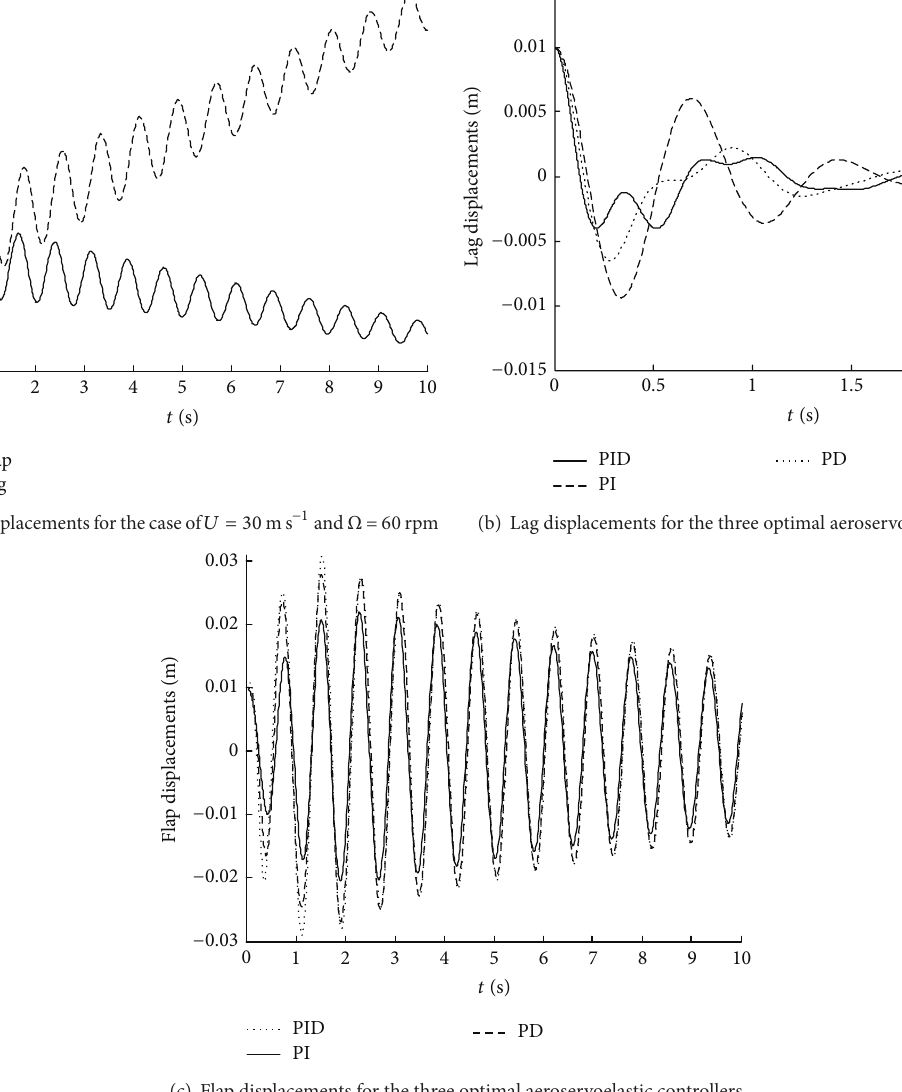
(c) Flap displacements for the three optimal aeroservoelastic controllers Figure 5: Aeroelastic instability and aeroservoelastic control case of 𝑈 = 30 ms −1 and Ω = 60